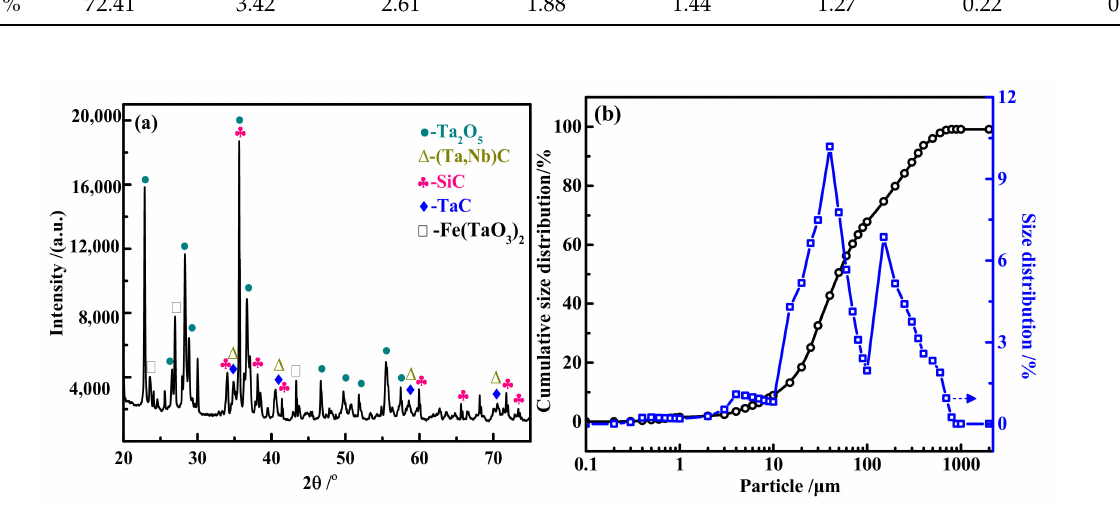
Figure 1. XRD pattern ( a ) and particle size distribution diagram ( b ) of the tantalum slag raw